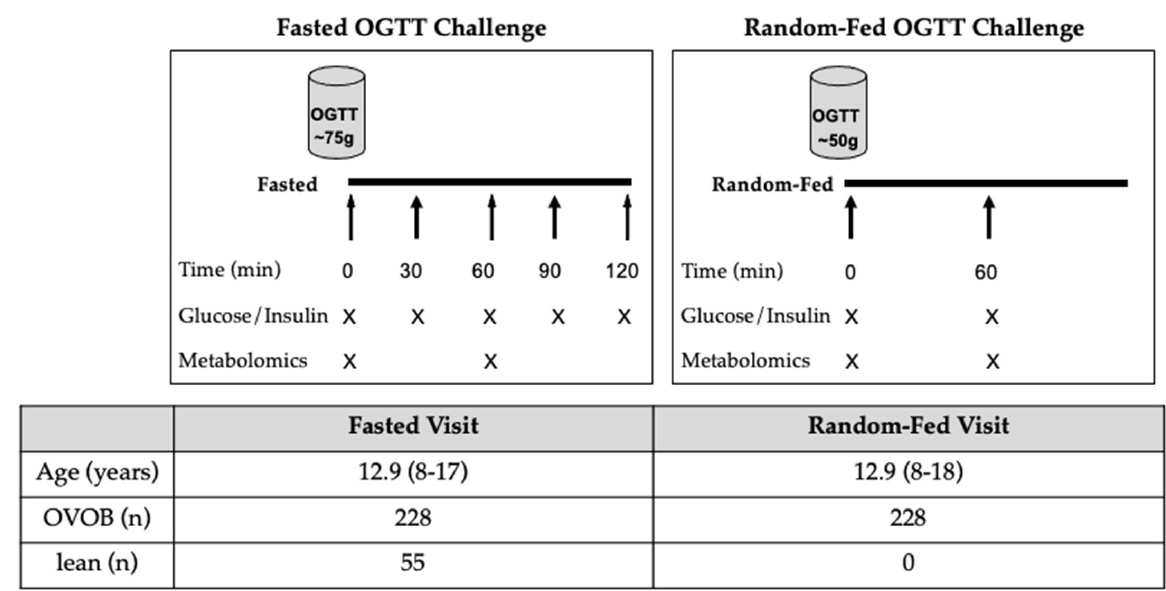
Figure 1. Study Design. Overweight and obese (OVOB) and lean participants were recruited prior to the first visit (Fasted Visit), where an oral glucose tolerance test (OGTT) (75 g) was administered in the fasted state. The OVOB participants returned approximately a week later for an OGTT (50 g) in a random fed state (Random-Fed Visit). Blood samples were collected before and during the OGTT and used for glucose, insulin, and untargeted metabolomics assays. Mean age and range of ages reported (years).